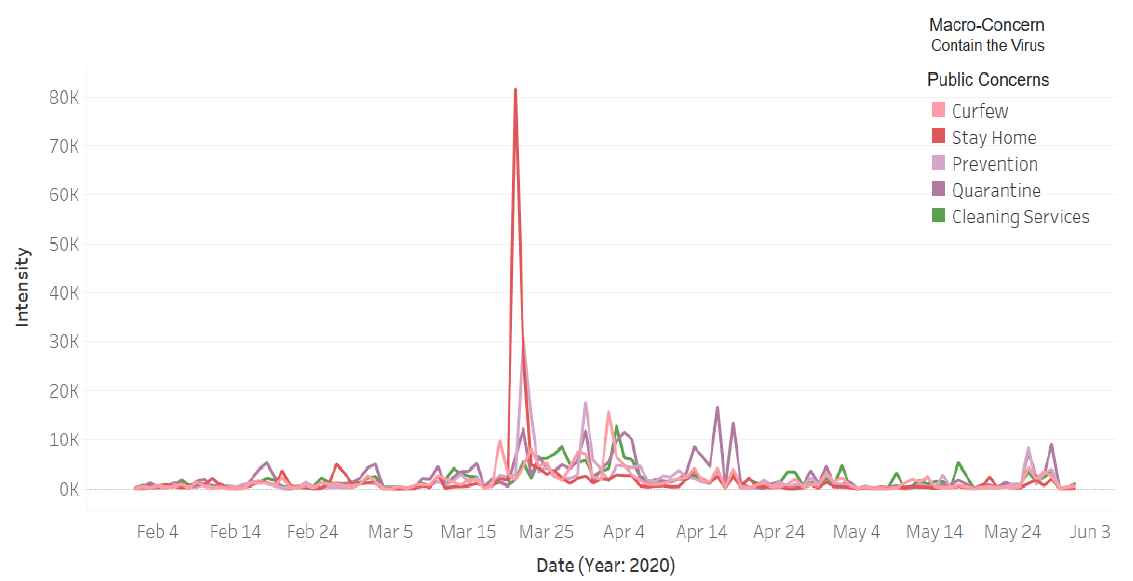
Figure 7. Daily Twitter activity for a macro-concern ( Contain the Virus ).